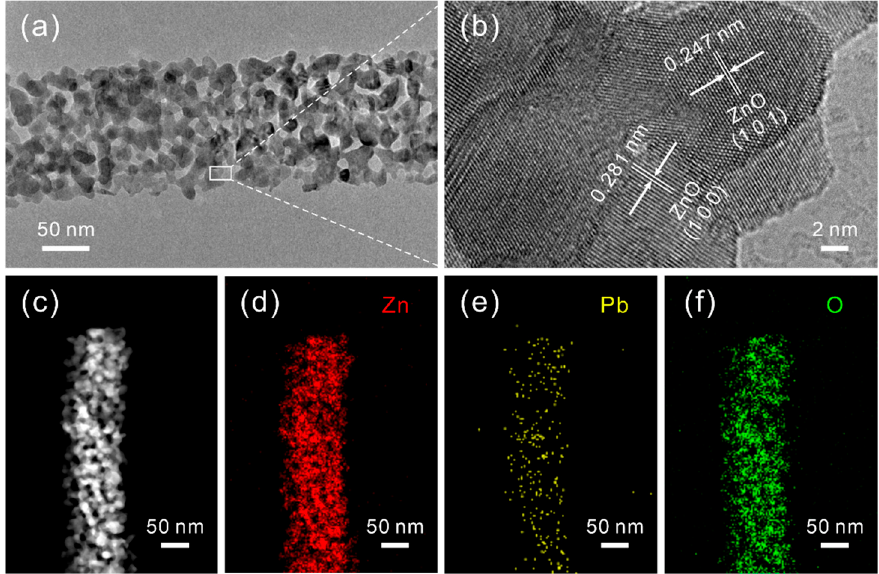
Figure 2. ( a ) TEM image of a single Pb-doped ZnO porous nanobelt, ( b ) its HRTEM image corre- sponds to the marked area, ( c ) its HAADF image and the corresponding elemental mapping patterns of ( d ) Zn, ( e ) Pb and ( f ) O.